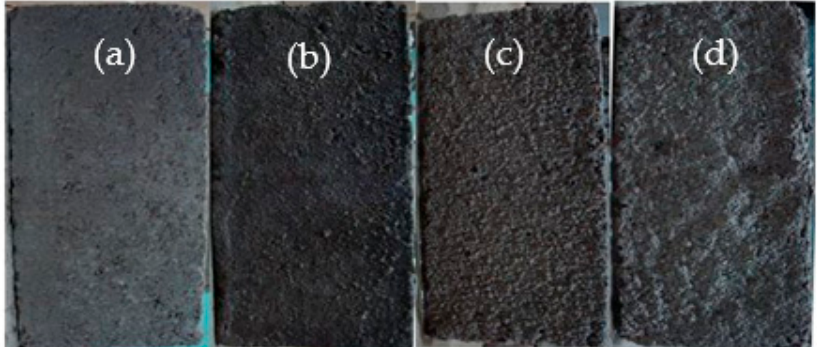
Figure 9. Apparent morphology of brick under different corrosion cycles. ( a ) 0, ( b ) 100 cycles, ( c ) 200 cycles, and ( d ) 300 cycles.